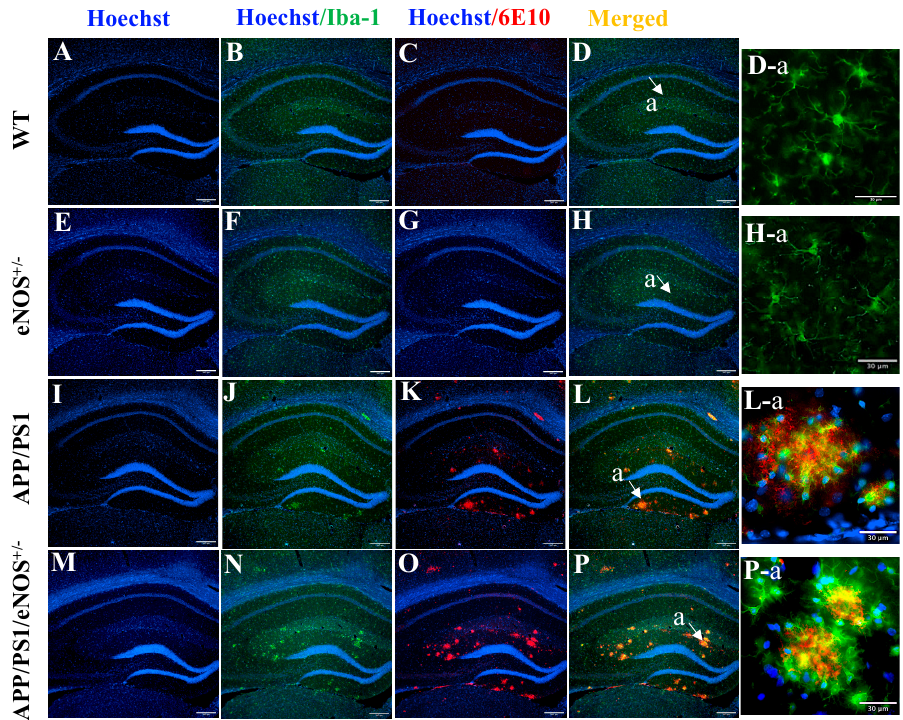
Figure 5. Representative immunofluorescent staining of Hoechst (blue; ( A , E , I , M )), Hoechst/Iba-1 (green; ( B , F , J , N )), Hoechst/6E10 (red; ( C , G , K , O )) and merged Hoechst/Iba-1/6E10 ( D , H , L , P ) in the hippocampus of 8-months old male WT, eNOS +/ − , APP/PS1 and APP/PS1/eNOS +/ − mice at 10X magnification (scale bar 200 μ m). High magnification (40X) images of merged Hoechst/Iba-1/6E10 staining in the area labeled a in WT ( D-a ), eNOS +/ − ( H-a ), APP/PS1 ( L-a ) and APP/PS1/eNOS +/ − mice ( P-a ) (scale bar 30 μ m).